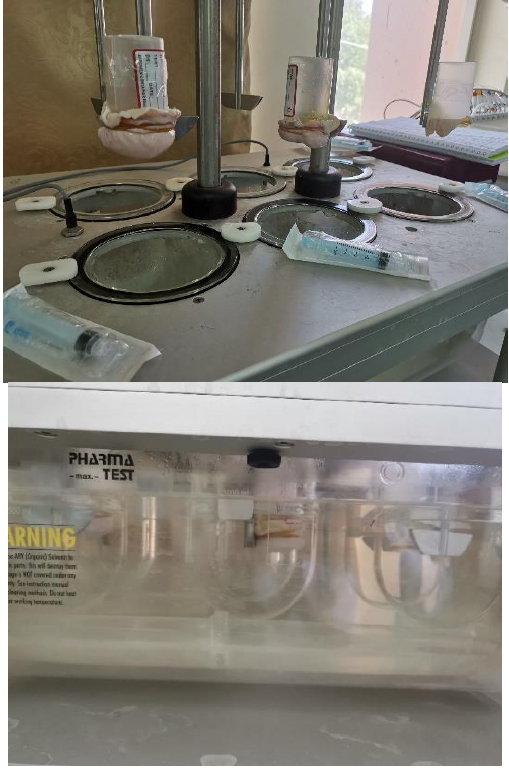
Figure 2. Modified drug permeation apparatus.